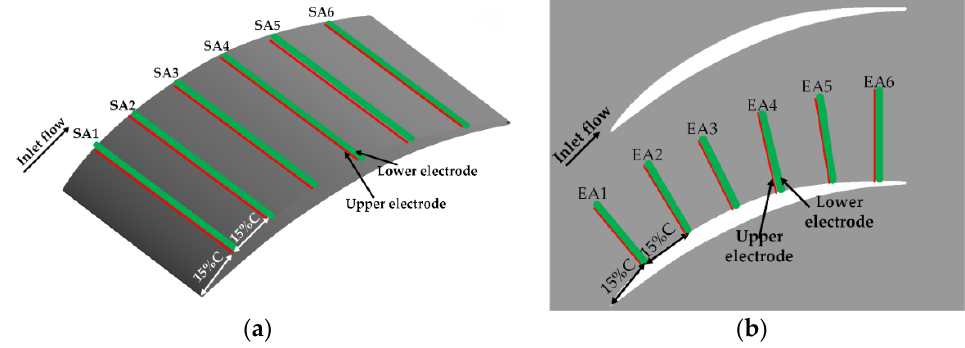
Figure 3. Plasma actuation layout. ( a ) Suction surface plasma actuation; ( b ) Endwall plasma actuation.